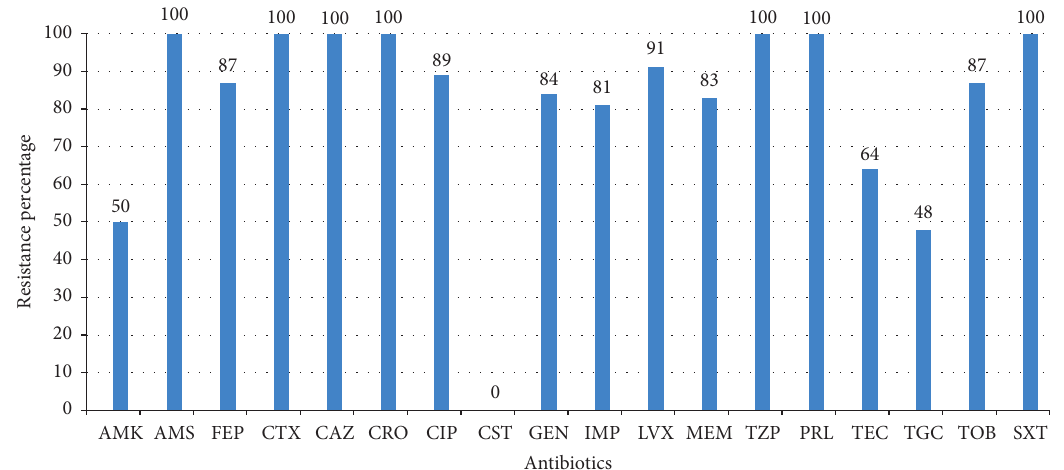
Figure 1: Antimicrobial resistance profile of 100 A. baumannii isolates. IMP: imipenem; MEM: meropenem; FEP: cefepime;